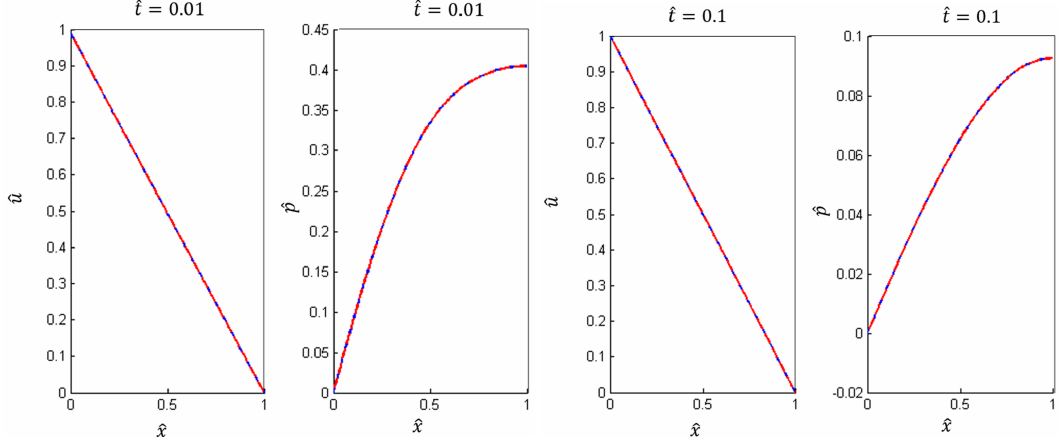
Figure 2. Comparison of the displacement and pore pressure at time ˆ t = 0.01 and ˆ t = 0.1 with hybrid splitting (continuous blue line) and fully coupled (discontinuous red line) methods for constant material